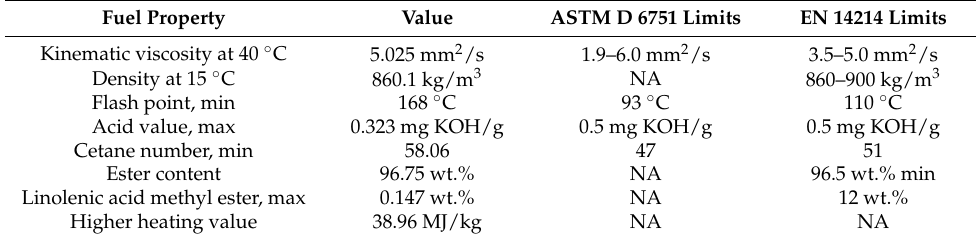
Table 3. Key fuel